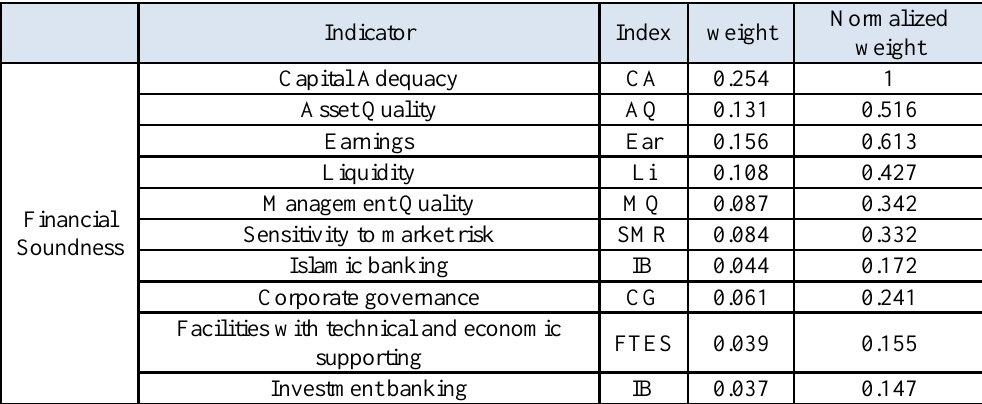
Table 9. Ranking the financial soundness indicators